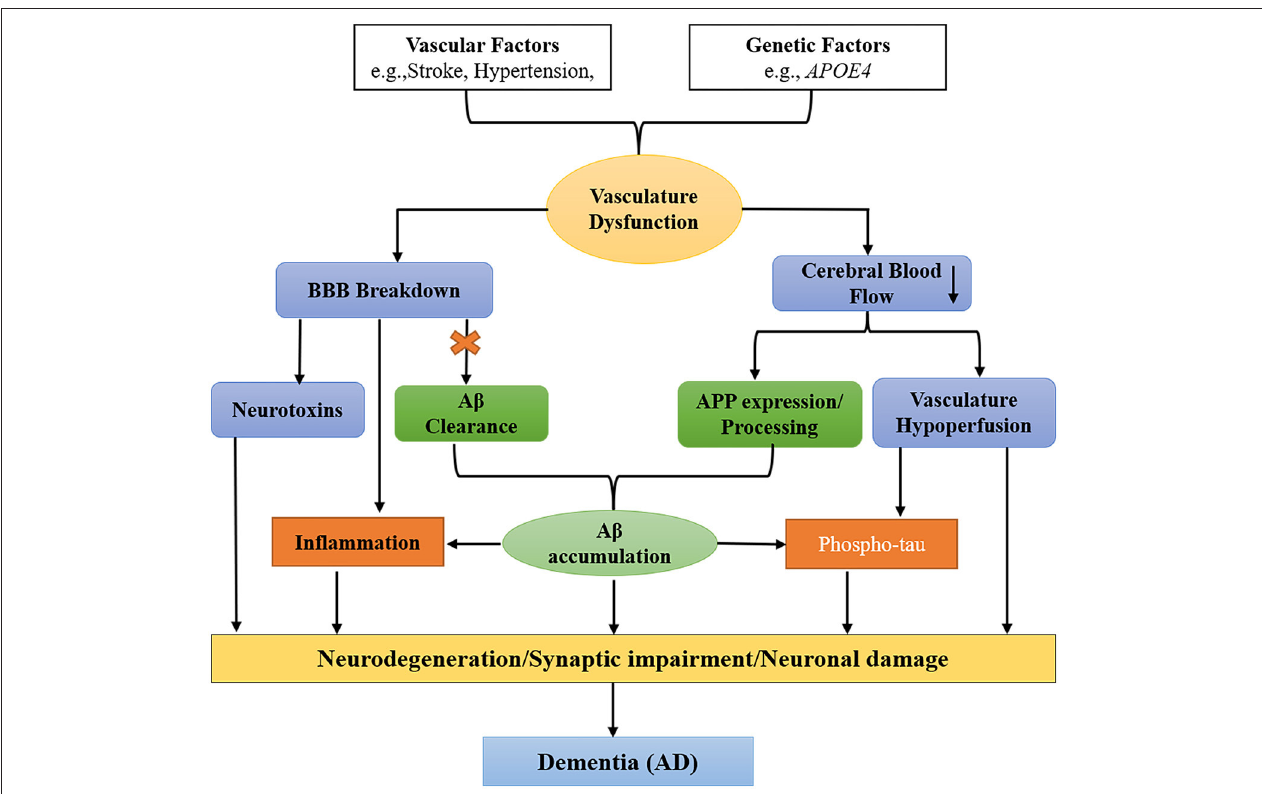
FIGURE 4 | Schematic diagram shows two pathways that cause dementia [specifically Alzheimer’s disease (AD)]. Vascular factors (stroke, hypertension, diabetes, etc.) and genetic factors (such as APOE4 ) cause defects in the vascular system leading to blood–brain barrier (BBB) impairment and oligemia (reduced cerebral blood flow), which finally correlate with dementia and neuronal degeneration. In the amyloid-beta (A β )-independent pathway (blue), vascular and genetic factors cause BBB breakdown and the secretion of neurotoxins from one side and oligemia from the other side. While in the A β -dependent pathway (green), the first BBB breakage impairs A β clearance and the amyloid precursor protein (APP), resulting in the accumulation of A β in the brain. Vascular hypoperfusion and A β phosphorylate tau (p-tau) that forms neurofibrillary tangles (NFTs). Finally, both pathways cause neurodegeneration/synaptic impairment/neuronal damage leading to dementia (specifically